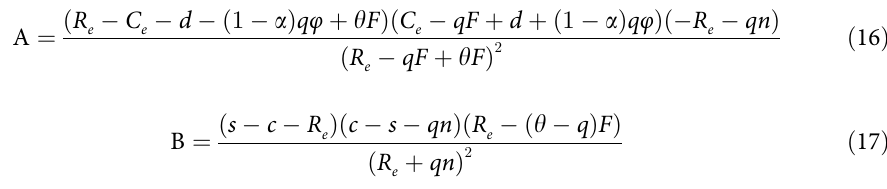
Through calculation, the value of the game system at the five local equilibrium points can be obtained, as shown in Table 3.